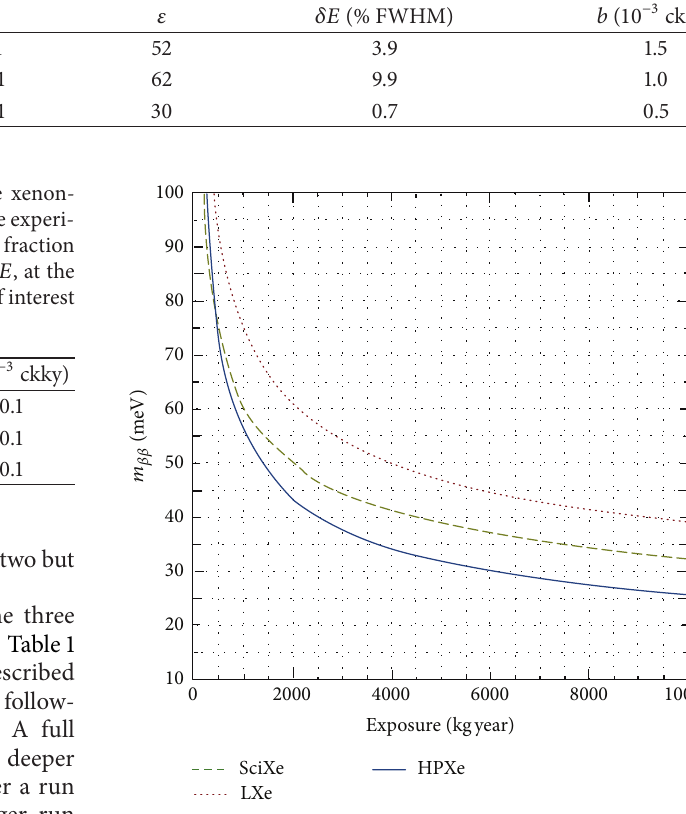
Figure 6: Sensitivity of the three technologies experiments as a function of the total exposure, assuming the parameters described in Table 2